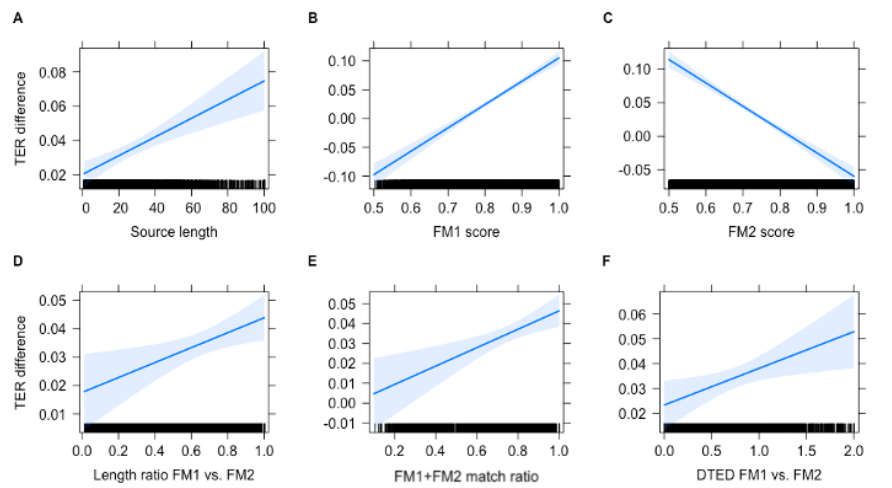
Figure 5. Effect plots for six significant features in the linear model predicting TER difference: ( A ) source length, ( B ) FM1 score, ( C ) FM2 score, ( D ) length ratio fuzzy match 1 and 2, ( E ) total combined match token ratio of fuzzy matches 1 and 2 to source length and ( F ) dependency-tree edit distance between both fuzzy matches. Shaded areas show 95% confidence